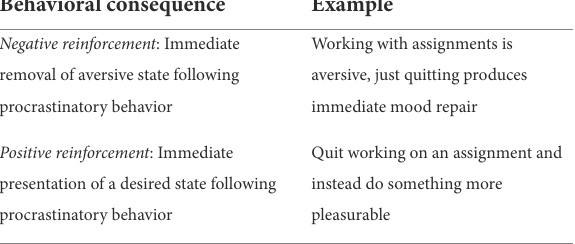
TABLE 3 Procrastinatory behaviors and consequences, given “working with an assignment” as the activity